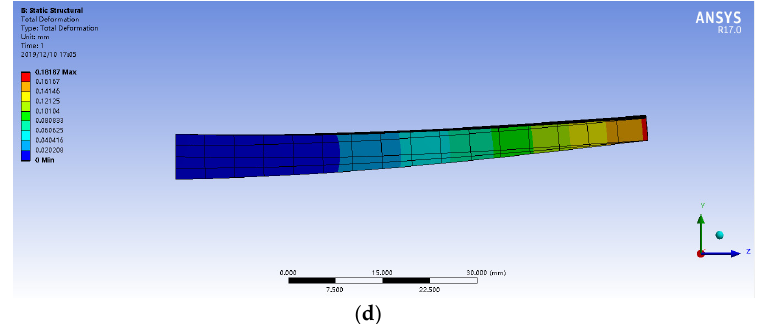
Figure 5. Deformation: ( a ) first layer; ( b ) second layer; ( c ) third layer; ( d ) fourth layer.